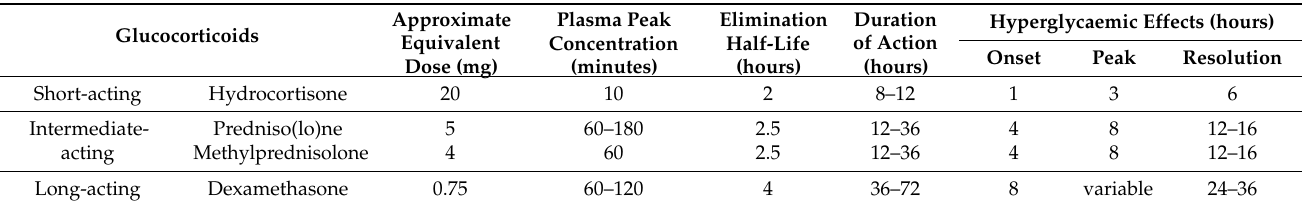
Table 1. Different corticosteroids and their equivalent doses, steroidal kinetics and potential to trigger hyperglycaemia.